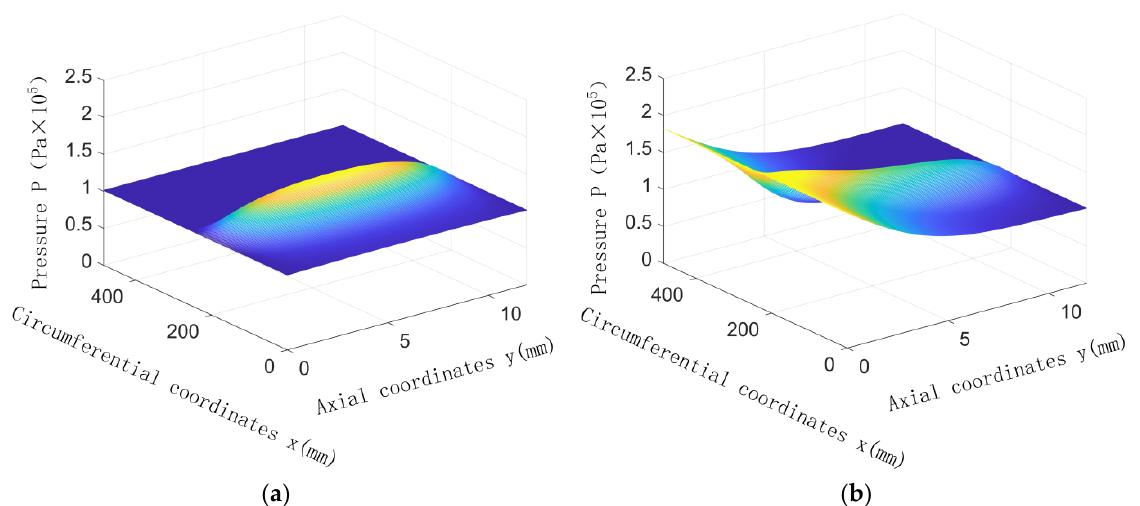
Figure 6. Mode 2 (only the outer rotor rotates): ( a ) without inlet pressure difference; ( b ) with inlet pressure difference.